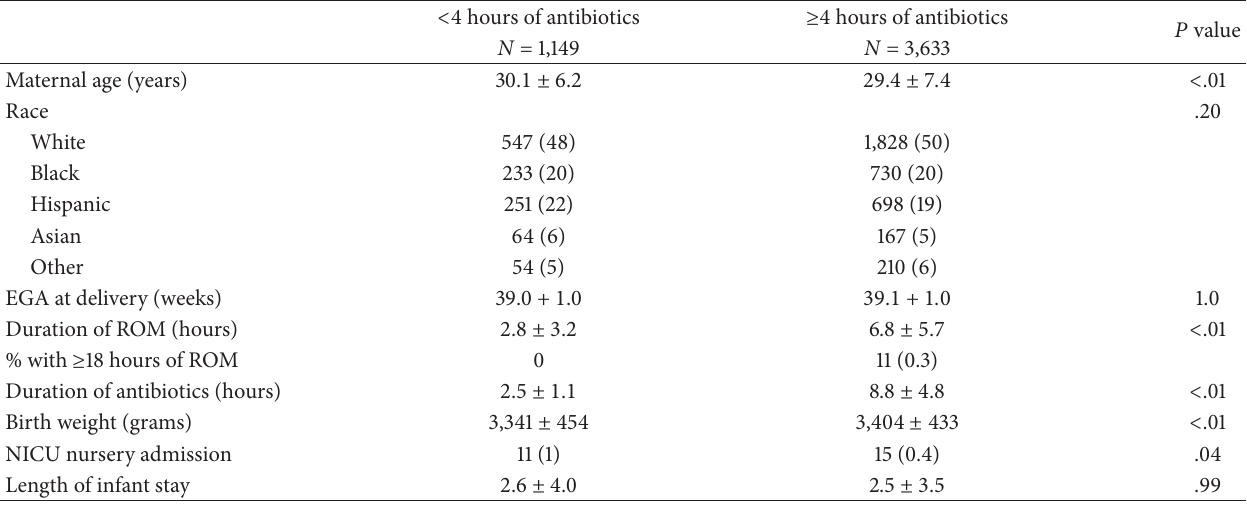
Table 1: Frequency of maternal and neonatal characteristics by the duration of exposure to intrapartum antibiotic therapy for group B streptococcus.